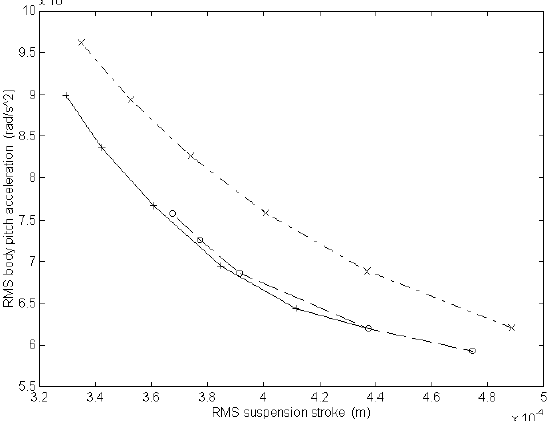
Figure 10. Tire normal force variation vs. roll acceleration.